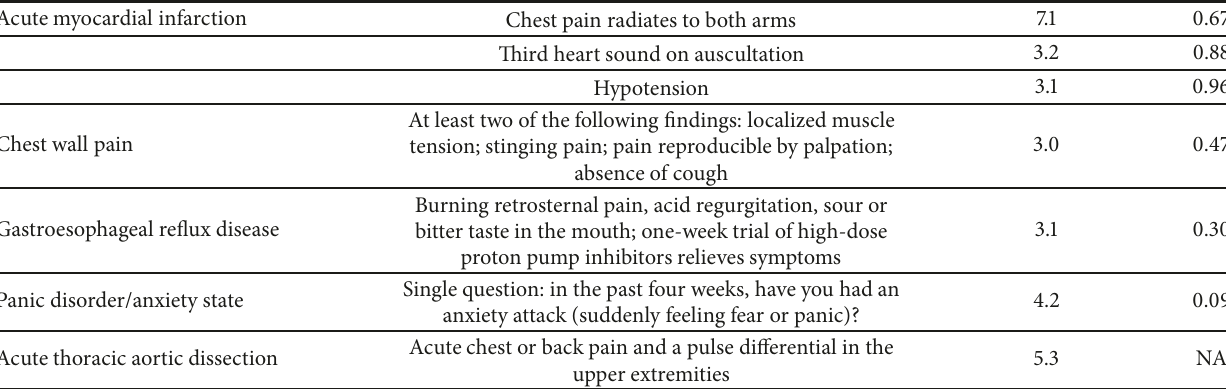
Table 3: Differential diagnosis of chest pain, adapted from Conaghy et al.